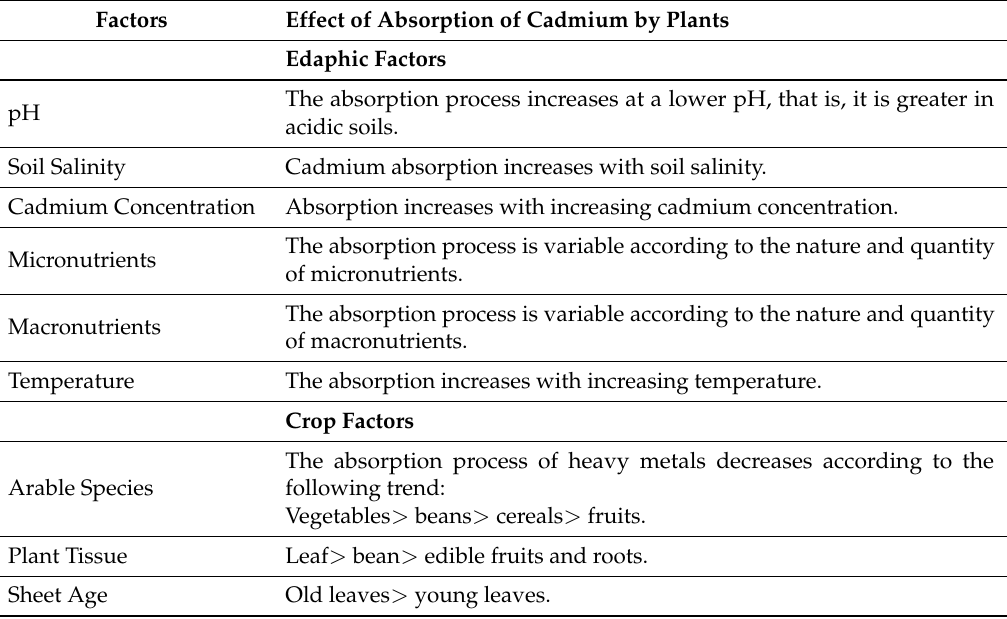
Table 1. Factors related to cadmium absorption processes